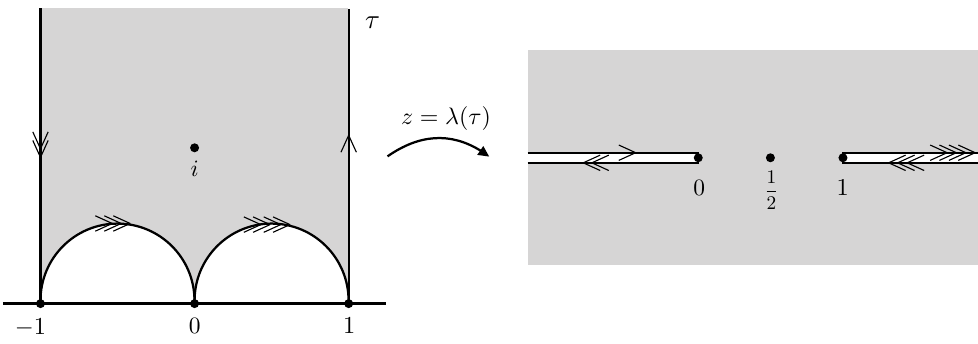
Figure 4 . Left: the fundamental domain of (cid:0)(2) in the upper half-plane. Right: its image in the space of the four-point cross-ratio z under the mapping (cid:28) fundamental domain is the complex plane without the branch cuts ( boundary segments are mapped as shown by the di(cid:11)erent